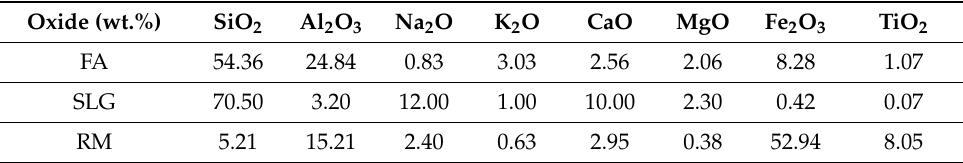
Table 1. Chemical Composition (expressed in wt.%) of the Starting Materials. Oxide